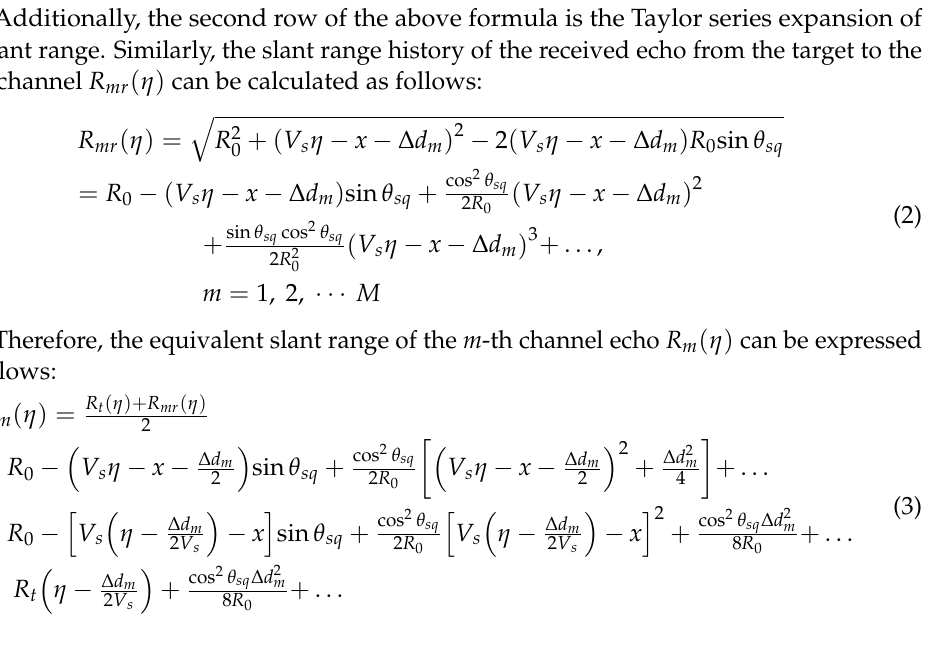
Figure 1. The model of the spaceborne SMC-SAR. ( a ) The observation geometry model of the SMC-SAR; ( b ) The 2D geometry of the azimuth-range plane model of the SMC-SAR.